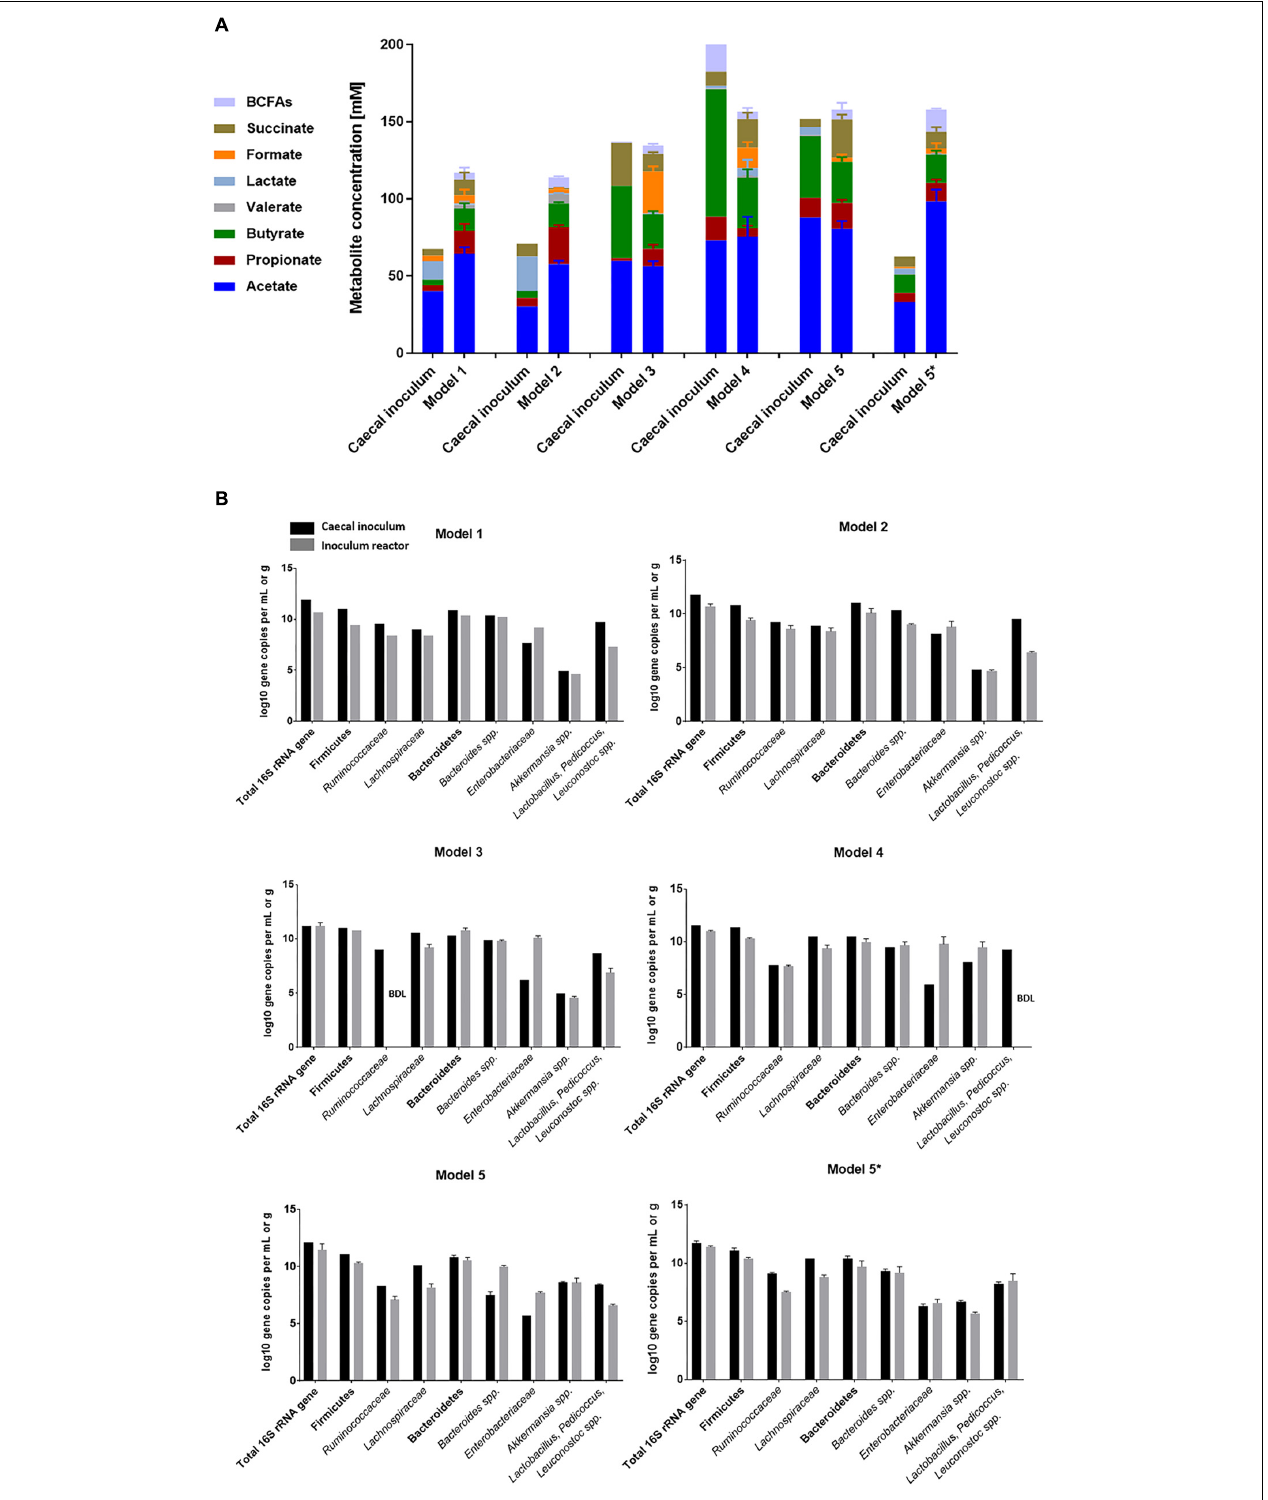
FIGURE 2 | Bacterial activity and composition of caecal inocula and reactor effluents of different models. (A) Concentrations of metabolites (mM) in caecal inocula and reactor effluents of stabilization phases expressed as mean metabolite concentrations with standard error. (B) Quantification of key bacterial populations in caecal inocula and fermentation samples of different models by qPCR and expressed as means ± SD log gene copies/g or mL when n > 1. BDL, below detection limit of 4 log10 gene copies.